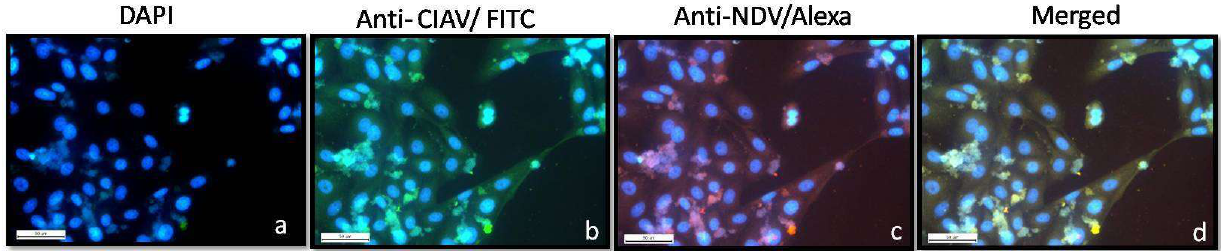
Figure 4. Immunofluorescence analysis of rNDV-R2B-CIAV expressing VP2/VP1 protein of chicken infectious anaemia virus ×60. ( a ) DAPI-stained cells; ( b ) cells expressing VP2/VP1 of CIAV (anti-CIAV/FITC); ( c ) cells expressing NDV proteins (anti-NDV/Alexa); ( d ) merged. (Scale bar: 50 µ